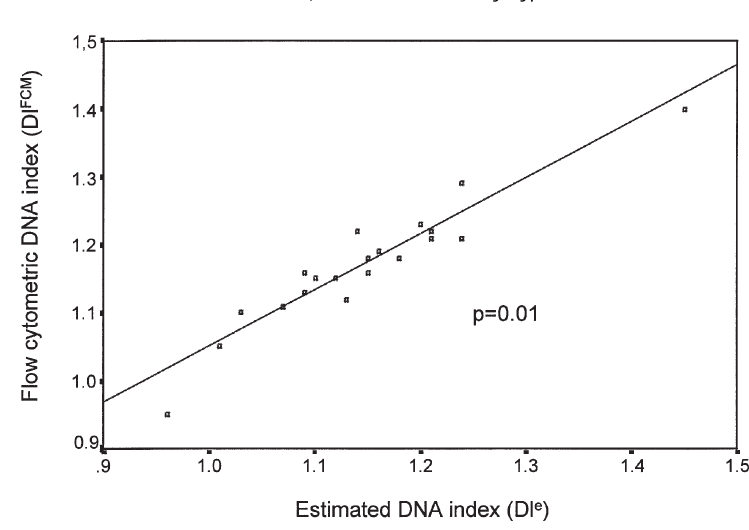
Fig. 3. Correlation between flow cytometric DNA index (DI FCM ) and DNA-index estimated from karyotype data (DI e